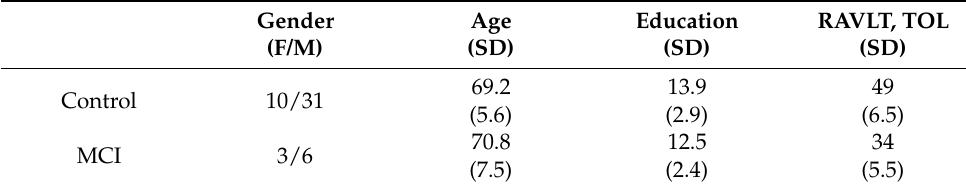
Table 1. Demographic characteristics of groups.